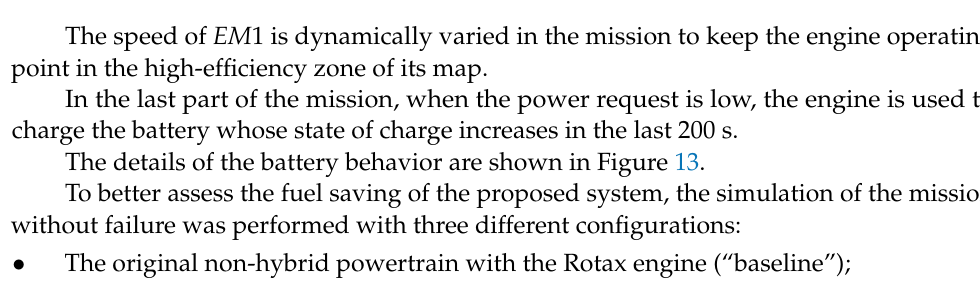
Figure 13. The behavior of the battery during normal